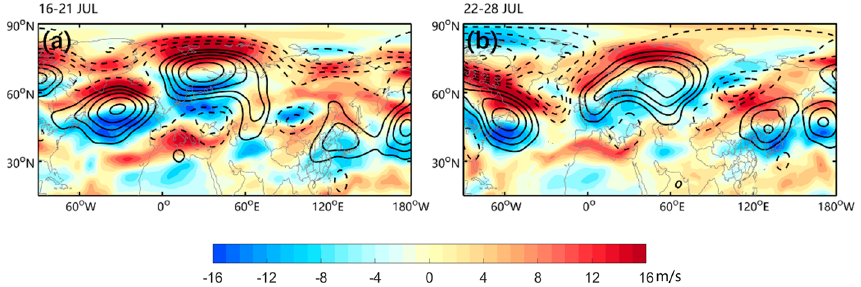
Figure 10. Composite 500 hPa geopotential height anomalies (contours, interval = 30; units: gpm) and 300 hPa zonal wind anomalies (shading; units: m/s) for ( a ) the midlatitude wave train period (16–21 July) and ( b ) the high latitude wave train period (22-28 July). The solid (dashed) contours denote positive (negative) 500 hPa geopotential height anomalies.